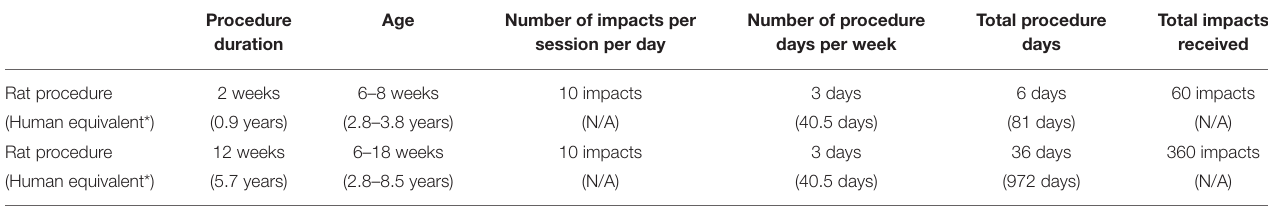
TABLE 1 | Summary of sub-concussion